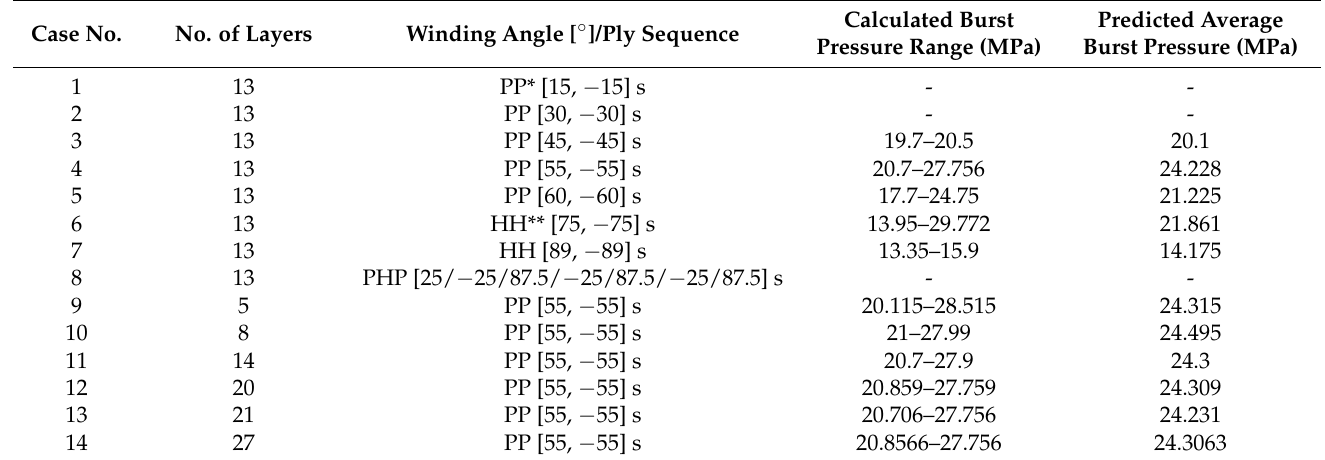
Table 2. FEA-based burst pressure analysis results for ASTM2585 based